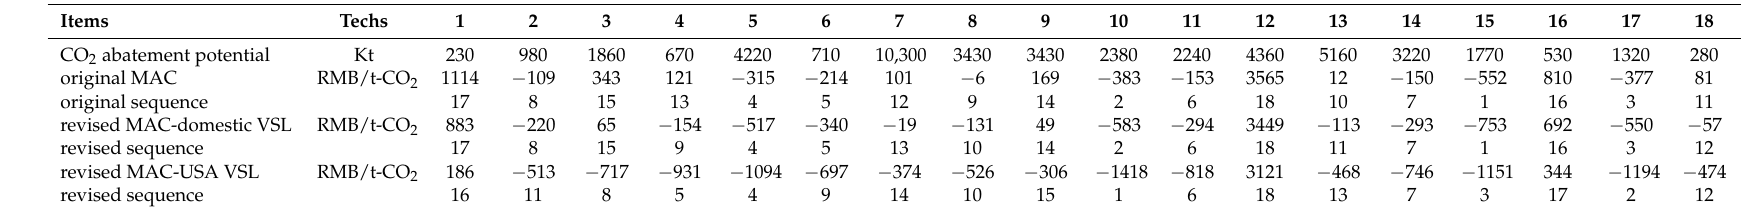
Table 4. Chemical sector CO 2 marginal abatement cost (MAC).